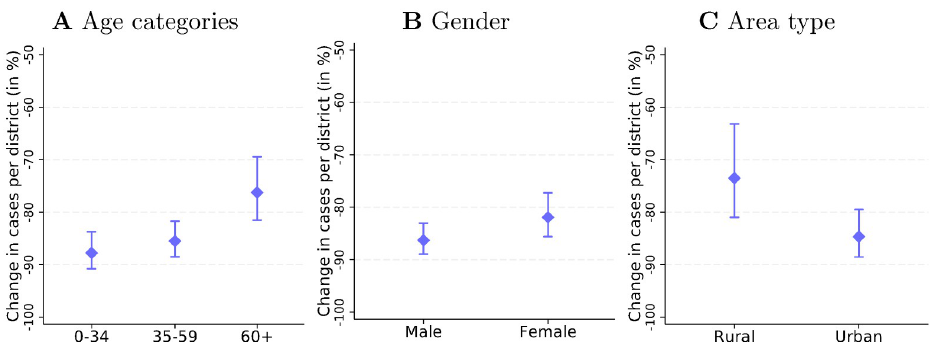
Fig 5. Heterogeneity of the social distancing effect on cases. Notes : The three panels of Fig 5 show how the effect of the nationwide social distancing policies on April 2 differed across age groups (Fig 5A), by gender (Fig 5B), and between urban and rural districts (Fig 5C). The estimates rely on sample splits and show the percentage of confirmed COVID-19 cases avoided by the nationwide policies. The vertical lines represent 95% confidence intervals based on district-level-clustered standard